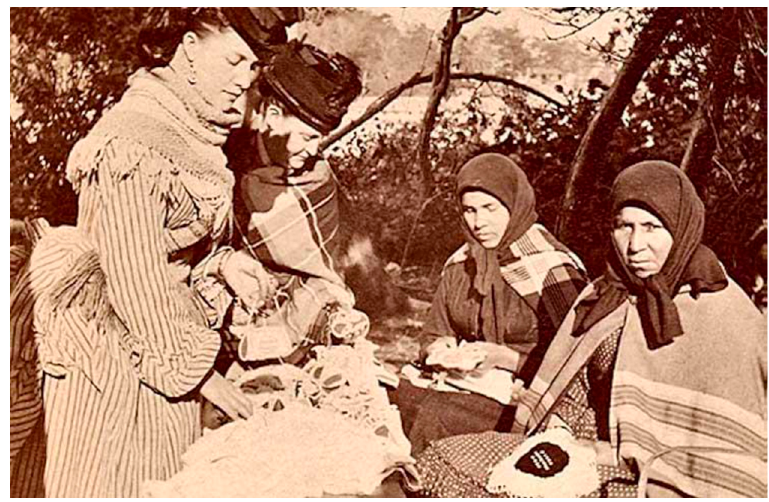
Figure 4. George Barker, Tuscarora women selling beadwork at Niagara Falls , c. 1870. Detail from a Stereoview photograph, public domain.